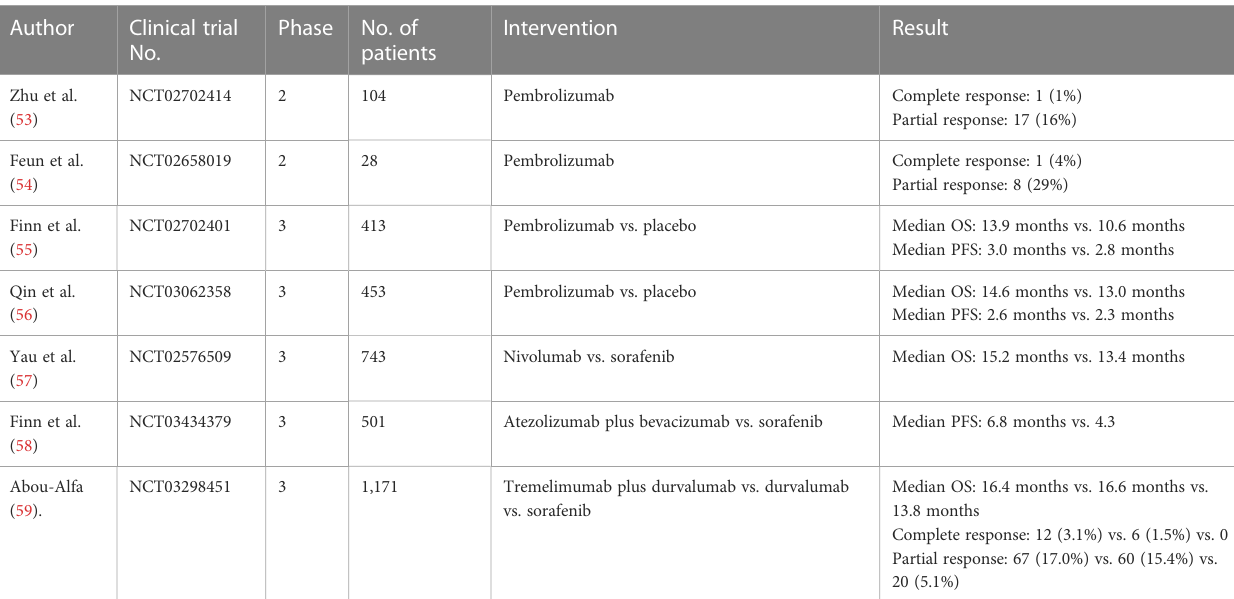
TABLE 1 Phase 2 to 3 clinical trials of immunotherapy against